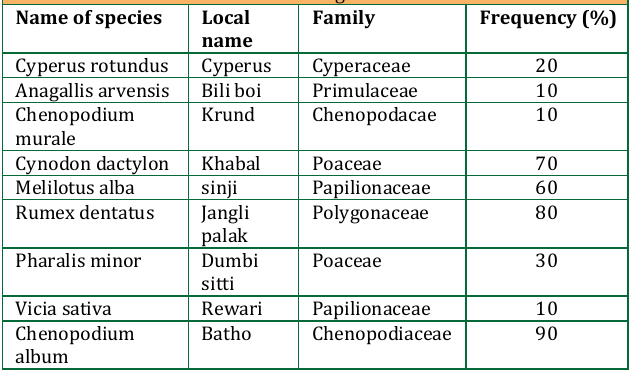
Table 9: Frequency of weed infesting in wheat field Kot Addu district Muzzafargarh Name of species